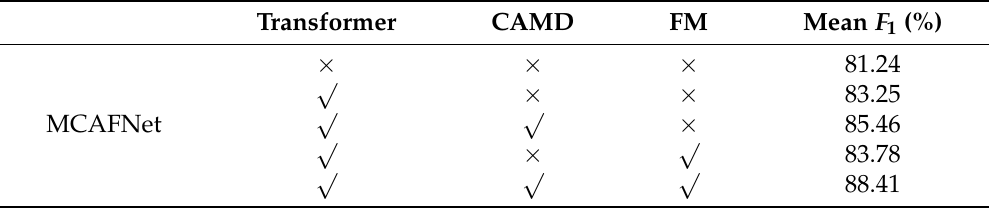
Table 1. The influence of each module on the MCAFNet’s